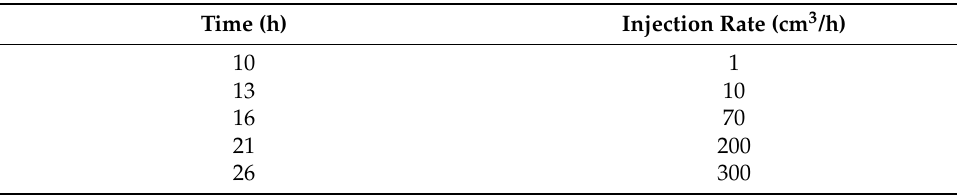
Table 4. Simulation time and injection rates for verification